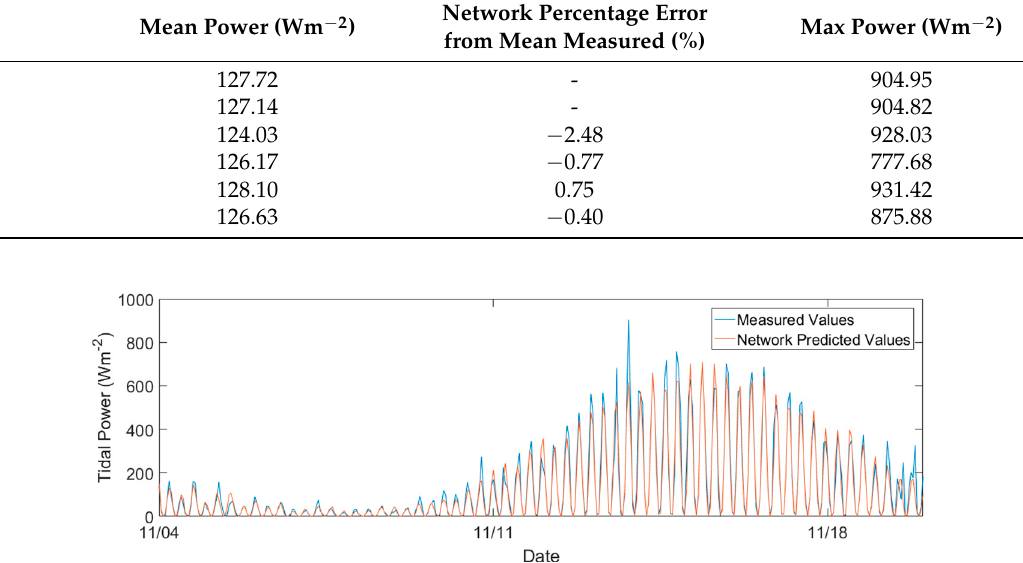
Figure 7. Extract of time series of measured and predicted current power. Blue: measured values, and orange: network prediction.